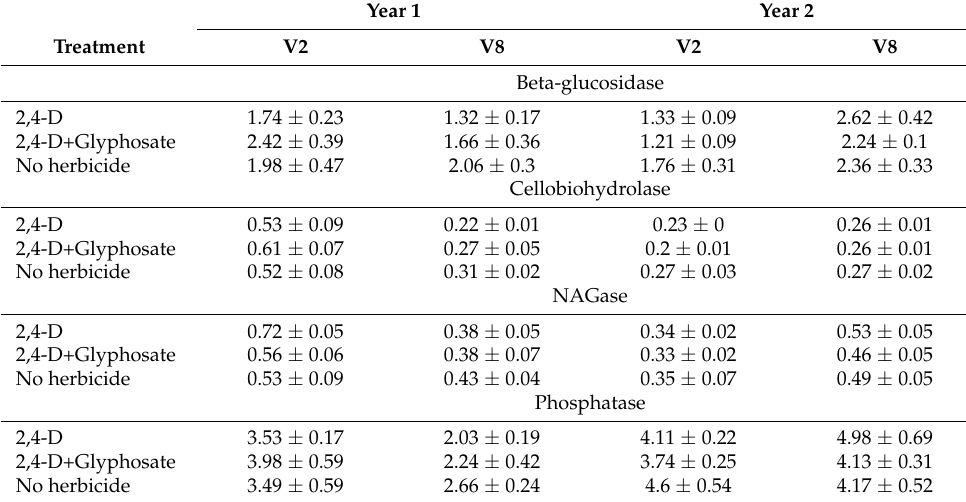
Table 4. Soil enzyme activities in the rhizosphere of maize plants one week following herbicide treatment at the V2 and V8 developmental stages